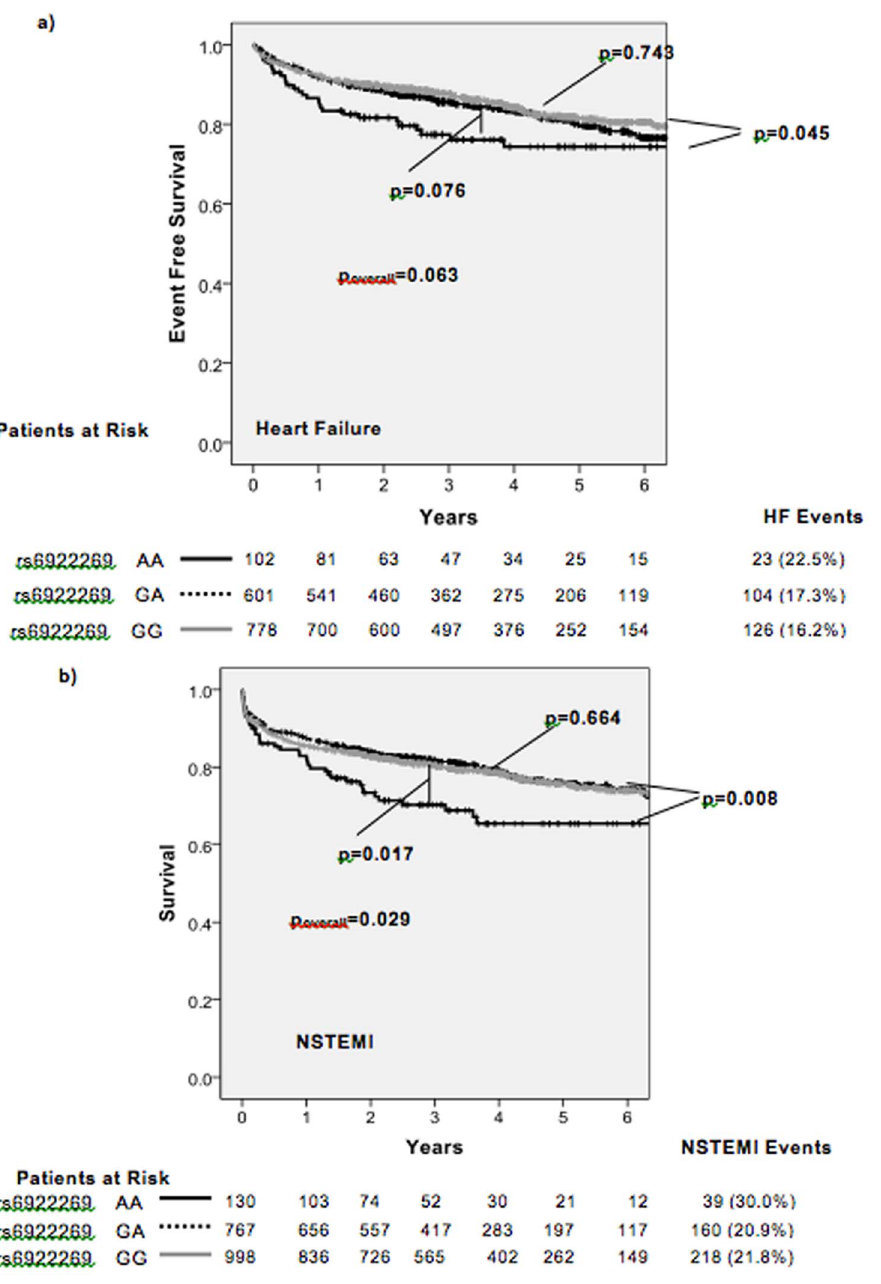
Figure 3. Kaplan-Meier analysis of event free survival to a) first HF admission, b) first NSTEMI admission stratified by rs6922269 genotype.